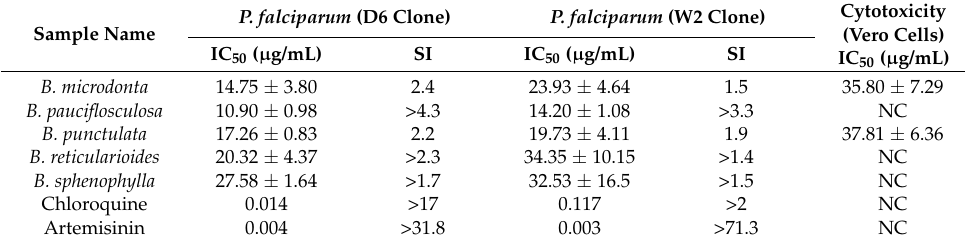
Table 2. Activities of essential oils of Baccharis species against Plasmodium falciparum